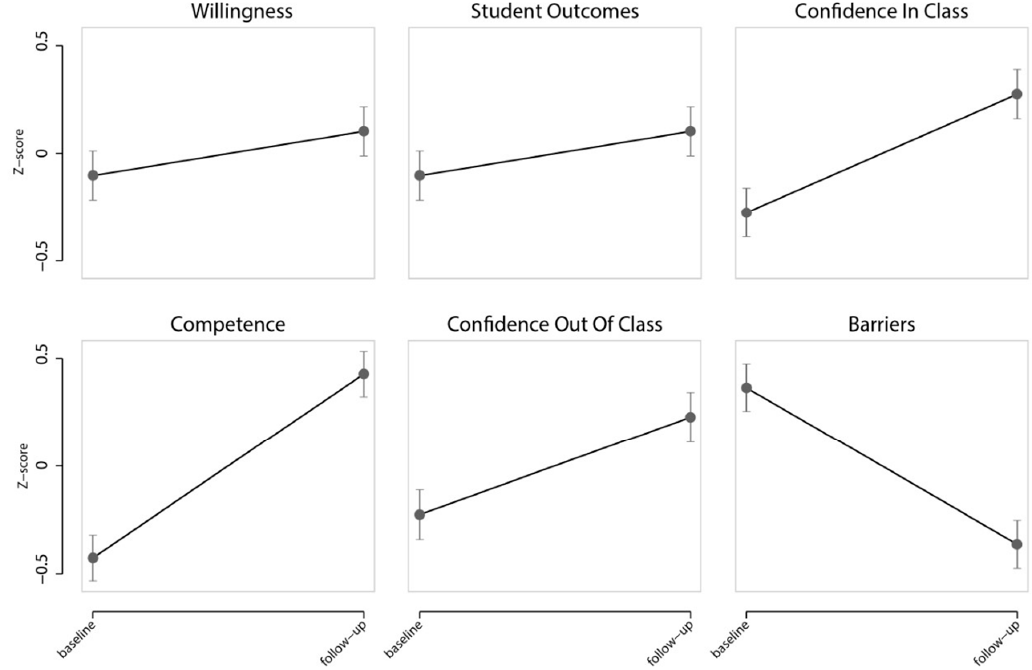
Figure 3. Changes in pre-service teachers’ perceptions on using physically active pedagogic strategies following Transform-Ed!.